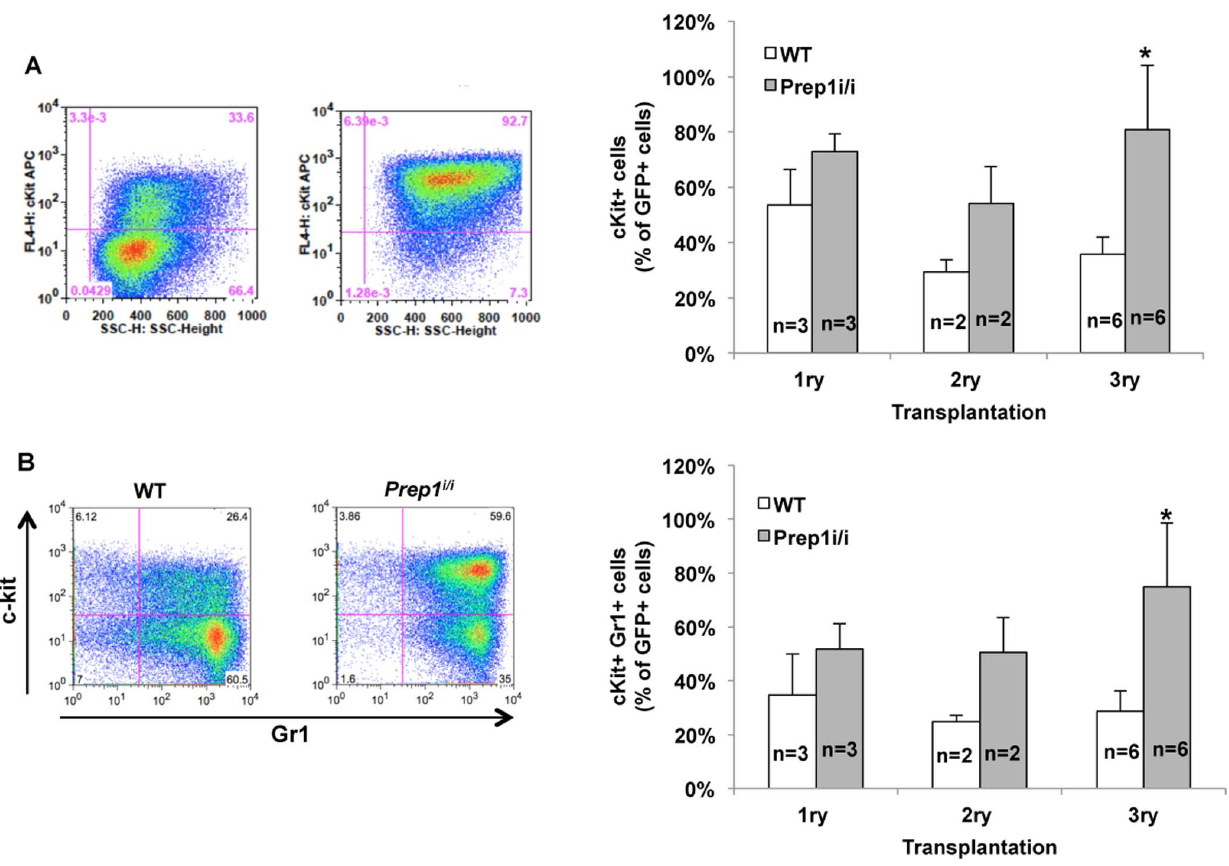
Figure 3. In vitro characterization of Prep1 i/i and WT leukemic cells. ( A ) FACS plots show c-Kit expression on GFP-positive cells in leukemic WT or Prep1 i/i BM cells (right side). Bar graph represents the percent of c-Kit positive cells on GFP-positive population on BM cells from different BMTs (left side). Error bars indicate SD. *p-value , 0.001. ( B ) FACS profiles show c-Kit and Gr-1 expressions on BM from mice with AML induced by transplantation of Prep1 i/i or WT cells overexpressing Meis1-HoxA9 (left side). Bar graph shows the percent of cells co-expressing c-Kit and GR-1 on BM from serially transplanted mice. Error bars represent SD. *p-value , 0.001. The number of the mice analyzed for each group is shown on the graph.